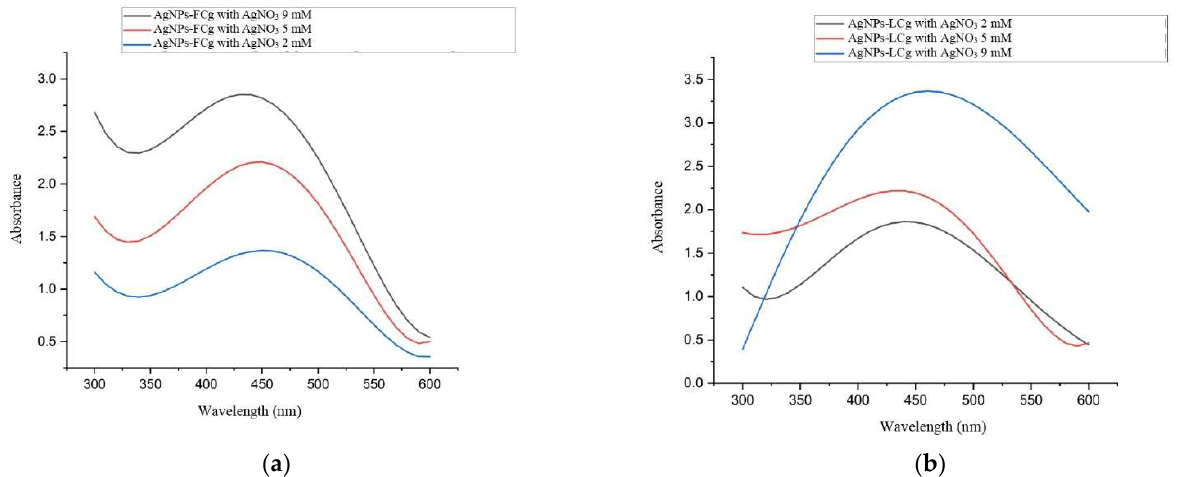
Figure 2. UV–Vis spectrophotometry characterization of ( a ) AgNPs-FCg and ( b ) AgNPs-LCg.